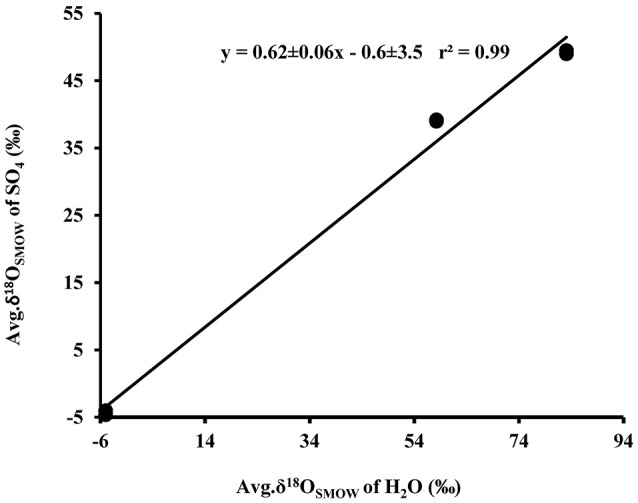
Plot of the average δ18OSO4 produced from biological (•) and abitoic (◦) oxidation of tetrathionate vs. average δ18OH2O used in the experiments (see Table 4).